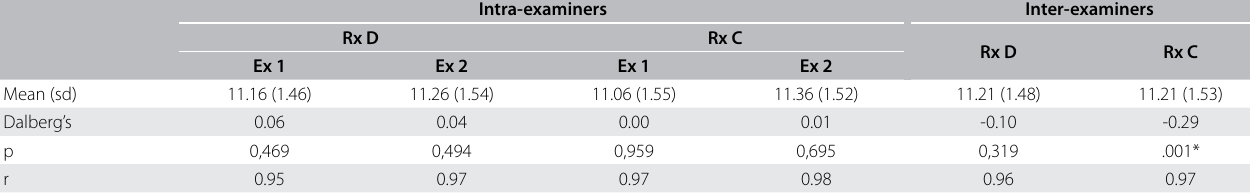
Table 1. Tooth length means and standard deviations (mm), random error (Dalberg’s equation), systematic error (p) and Pearson’s correlation coefficient (r) for intra and inter-examiners (Ex) reliability for digital (Rx D) and conventional (Rx C) images